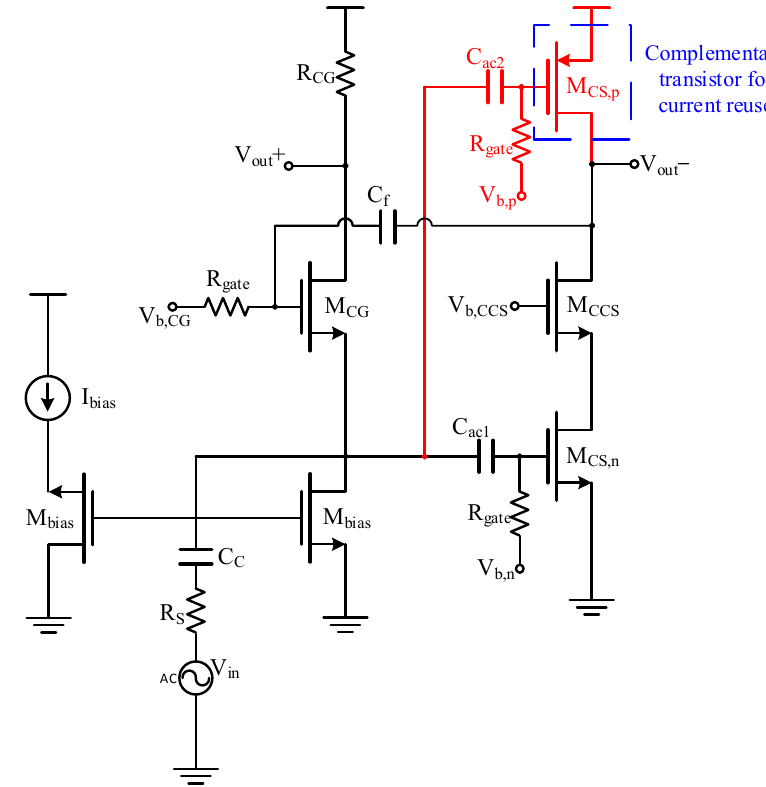
Figure 3. Proposed balun-LNA employing feedback and current reuse.